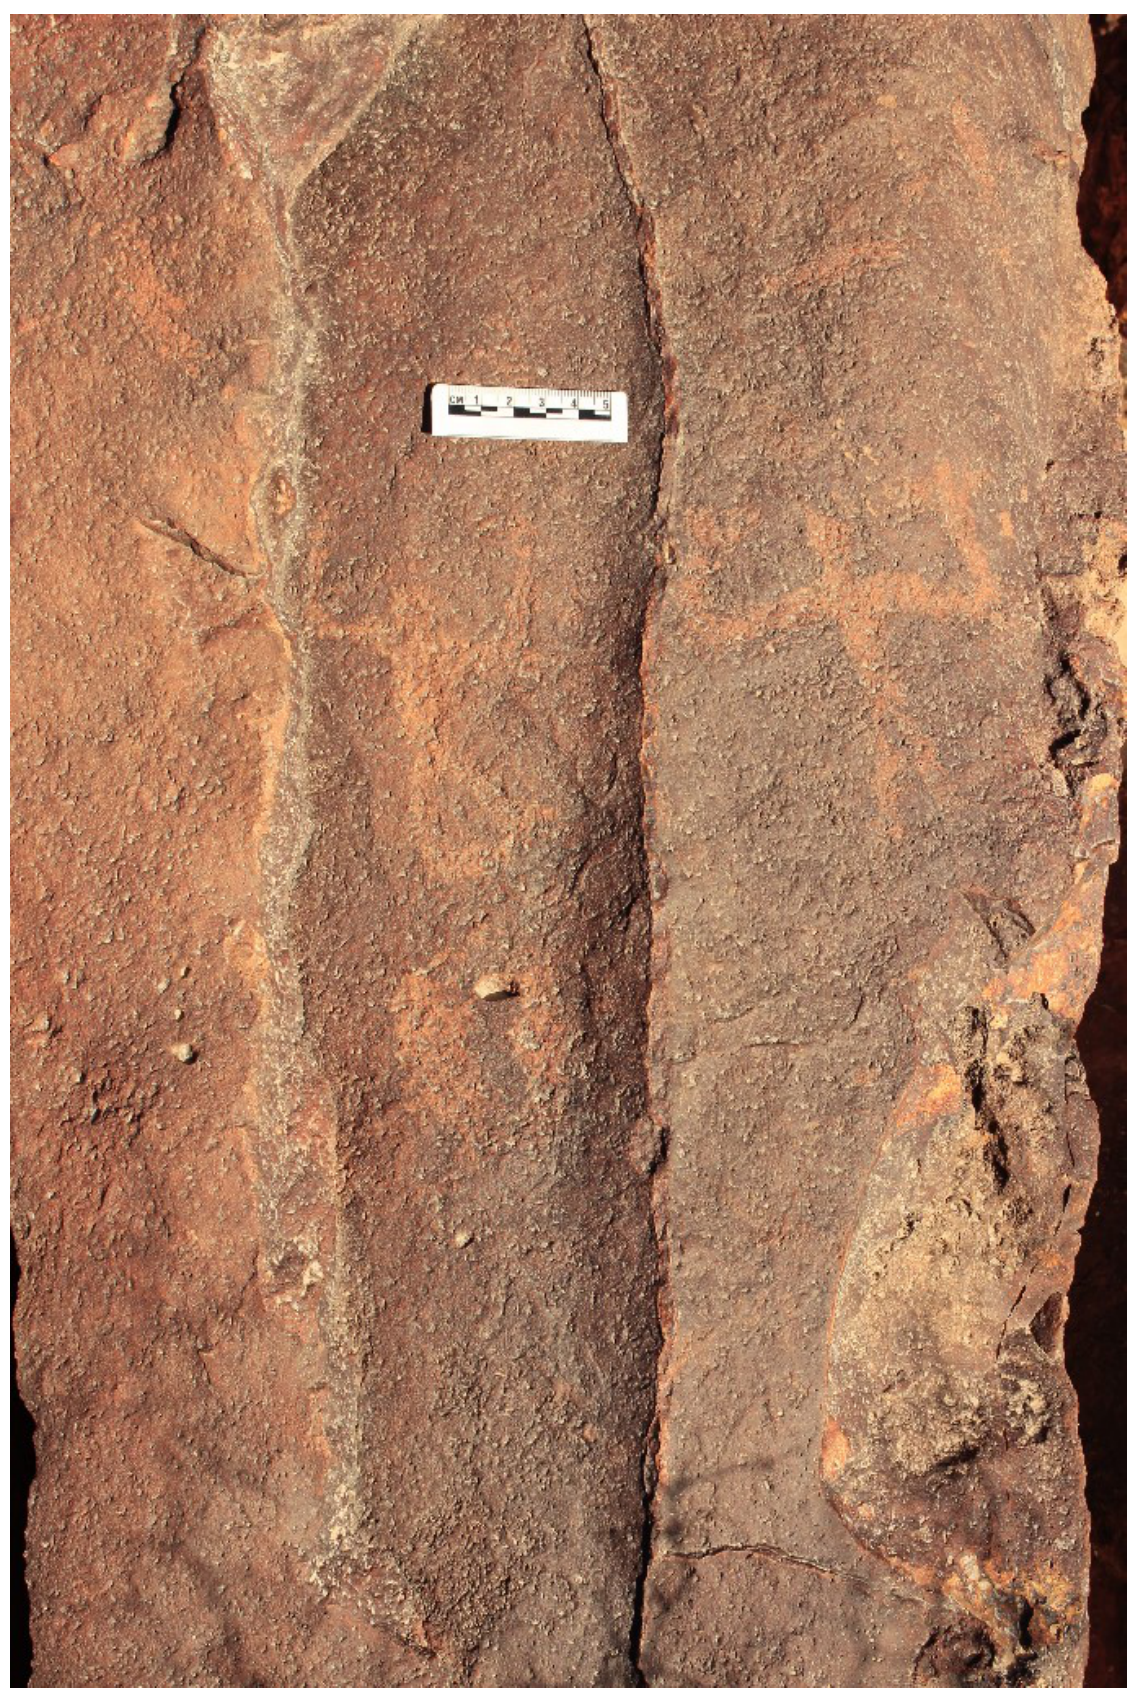
Figure 5 Two orant figures. Panel from Har Michia north (Photo by D.